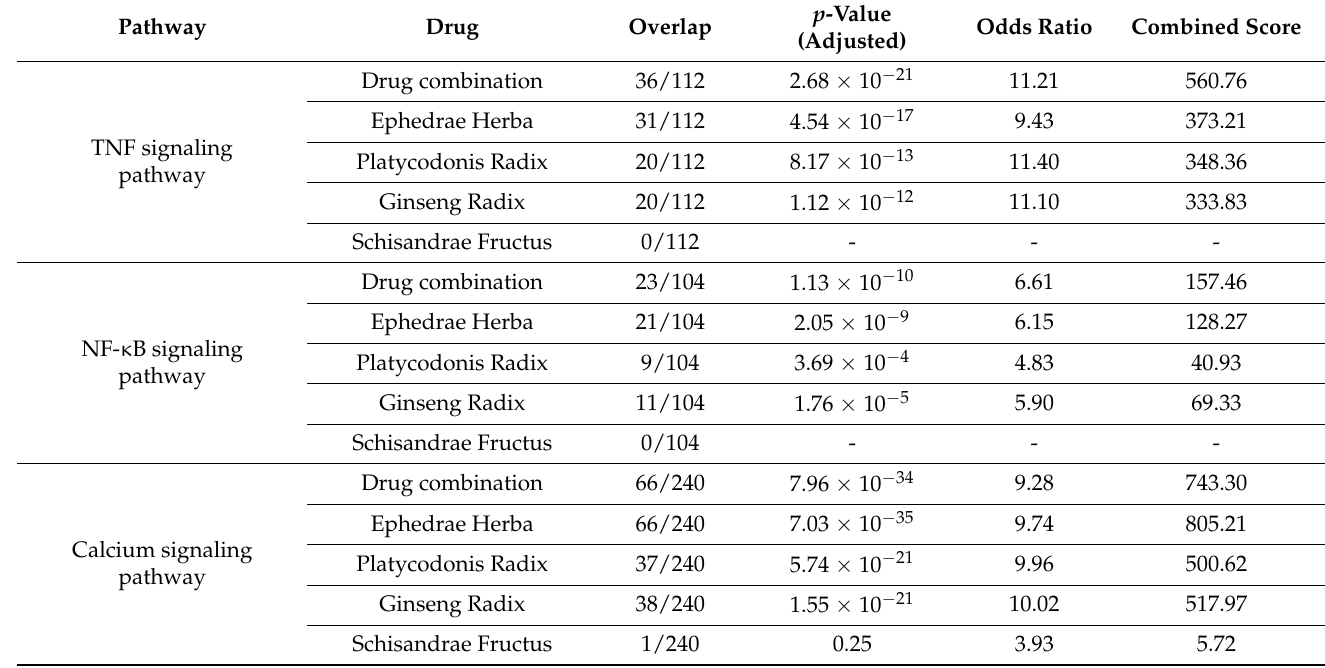
Table 5. Enrichment analysis results of the impact of each drug on the pathways related to TNF- α , IL-1 β , and